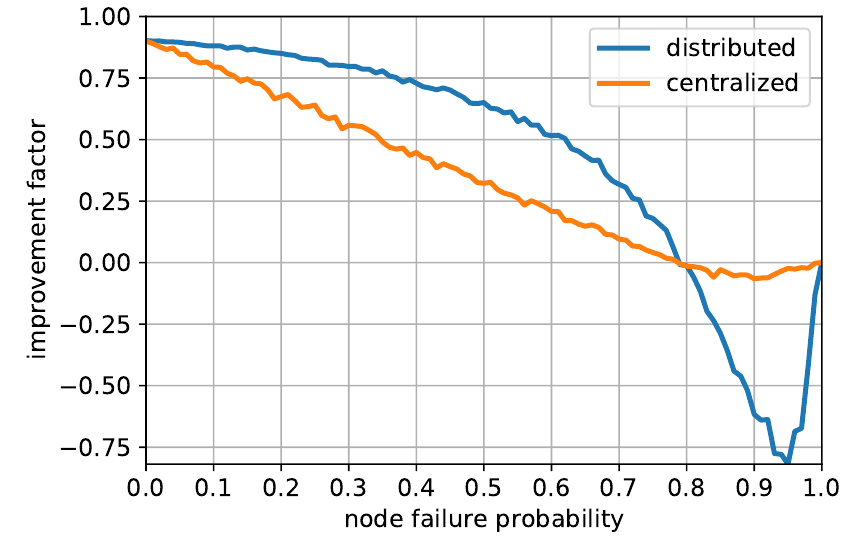
Figure 6. Comparison with centralized